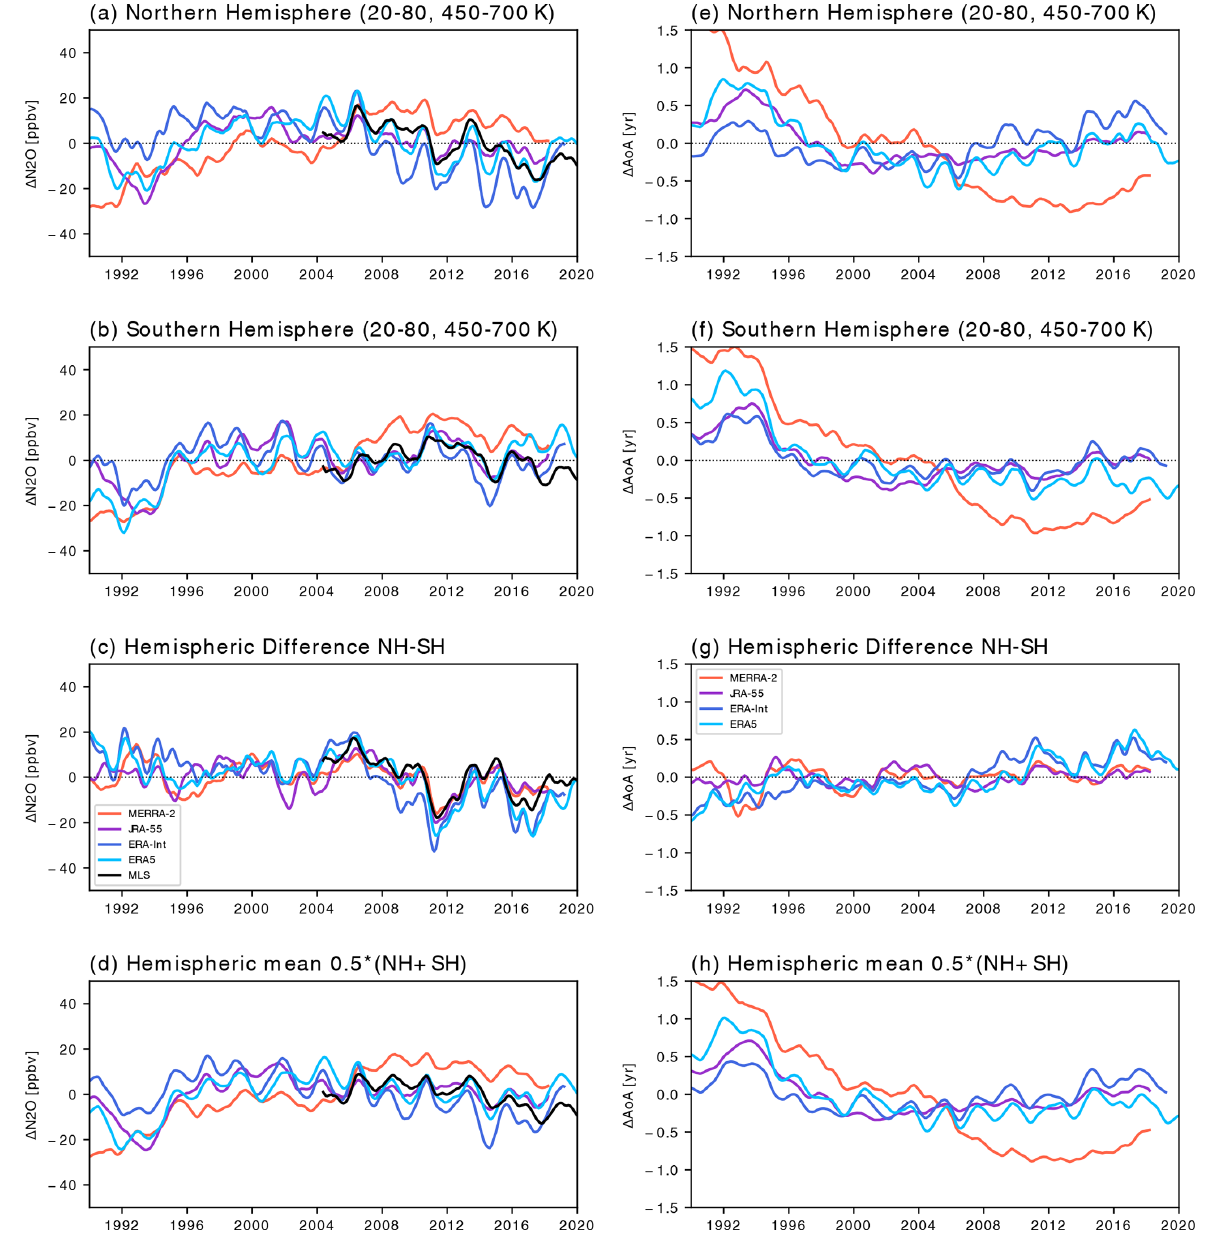
Figure 3. Time series of deseasonalized anomalies for N 2 O in (a) the NH and (b) SH, (c) the hemispheric difference (NH − SH), and (d) the hemispheric average (calculated as 0 . 5 · (NH + SH)) for the period 1990–2019 from CLaMS, driven with different reanalyses and from MLS satellite observations. The data have been averaged zonally and over the region 450–700K, 20–80 ◦ . (e–h) Same but for mean age from the CLaMS